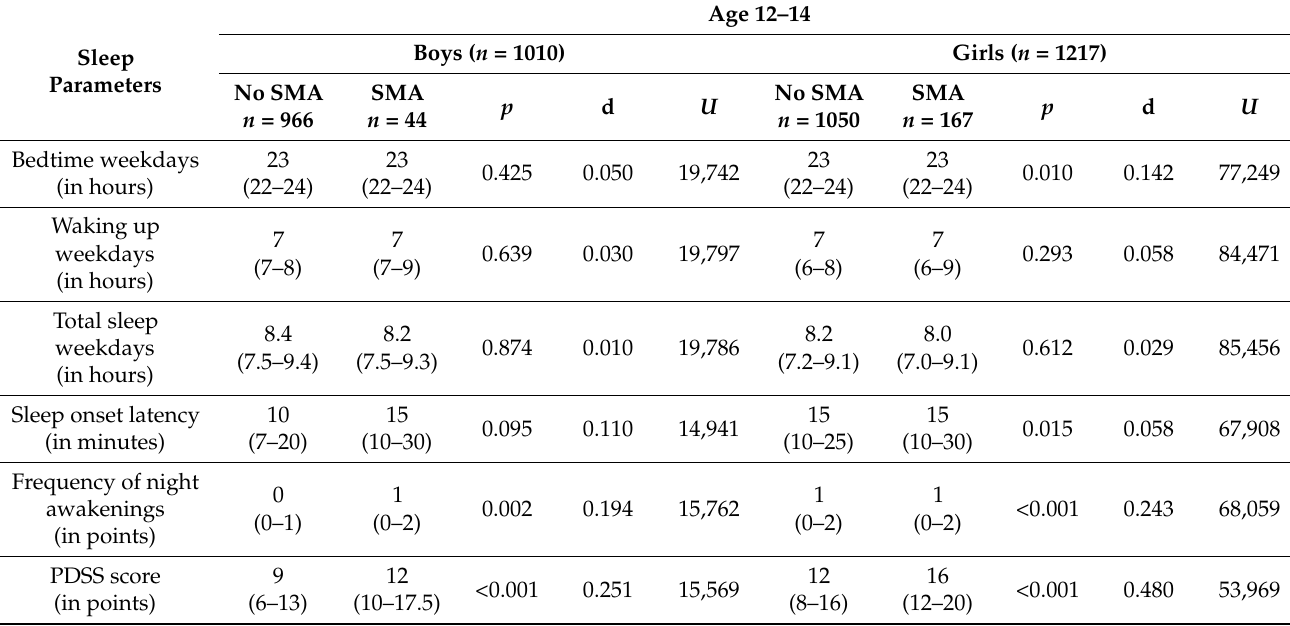
Table 7. Sleep parameters in adolescents aged 12–14 with social media addiction (SMA) verified with the Social Media Disorder Scale